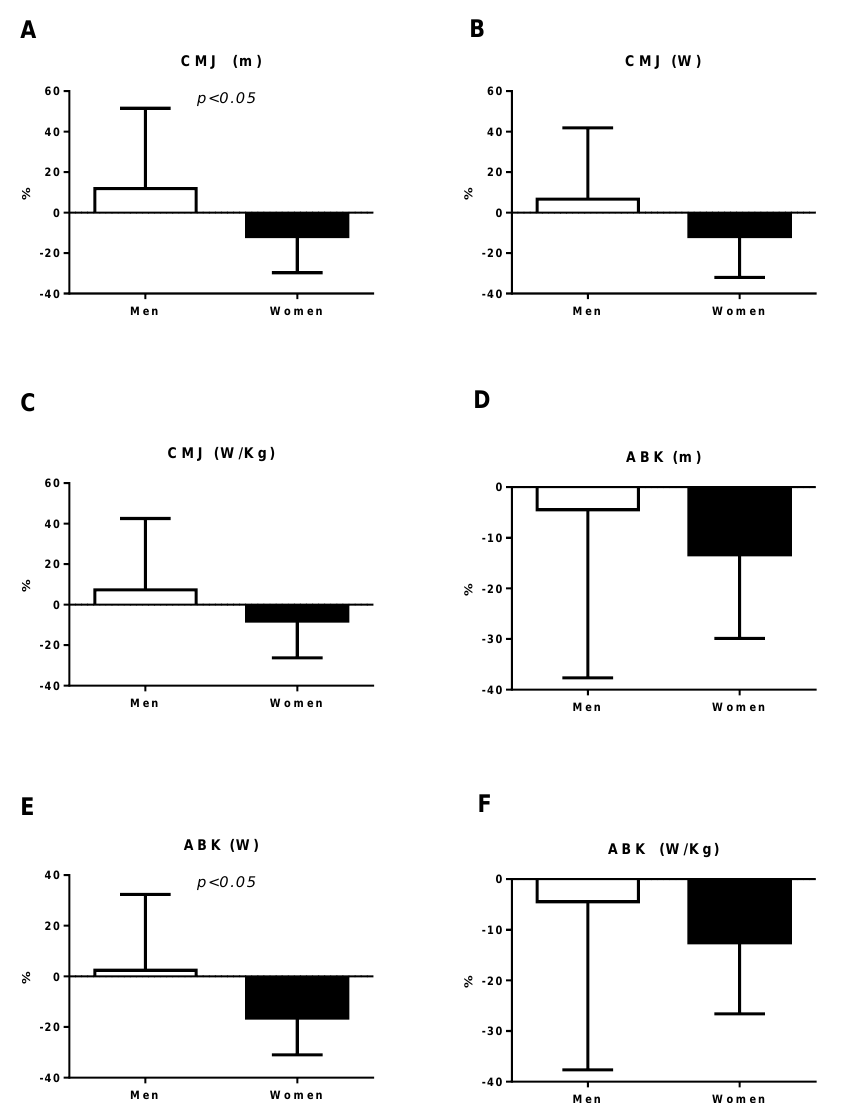
Figure 2. The percentages of change in the neuromuscular parameters (CMJ and ABK): ( A ) The percentage of change in CMJ height; ( B ) the percentage of change in CMJ watts; ( C ) the percentage of change in the watts in relation to body weight CMJ; ( D ) the percentage of change in ABK height; ( E ) the percentage of change in ABK watts; ( F ) the percentage of change in the body weight watts. CMJ: countermovement jump; ABK: Abalakov jump.